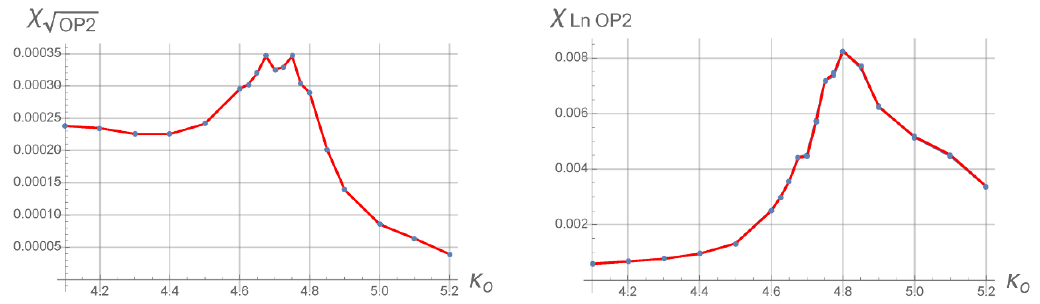
p Figure 6 . Susceptibility of OP 2 (left chart) and ln( OP 2 ) computed directly from raw data (line) and using approximations (4.6) and (4.7) (points). Data collected for the A (cid:0) C phase transition in the case of toroidal topology (cid:6) = T 3 for (cid:12)xed (cid:1) = 0 :